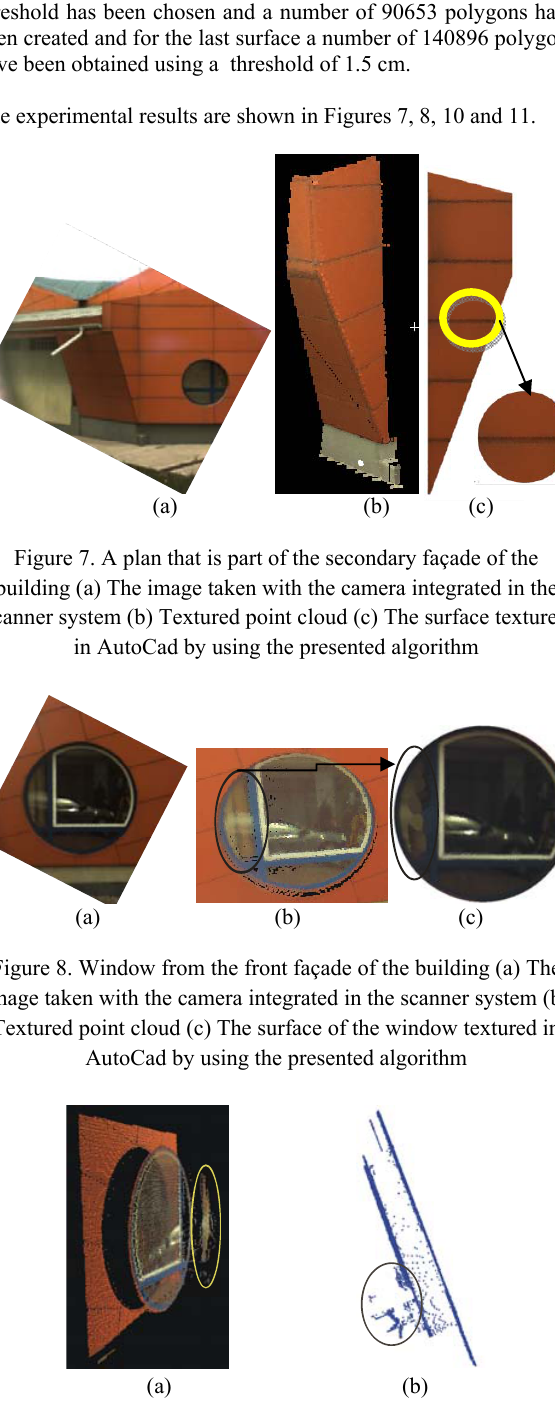
Figure 9. Point cloud reprezenting the surface of the